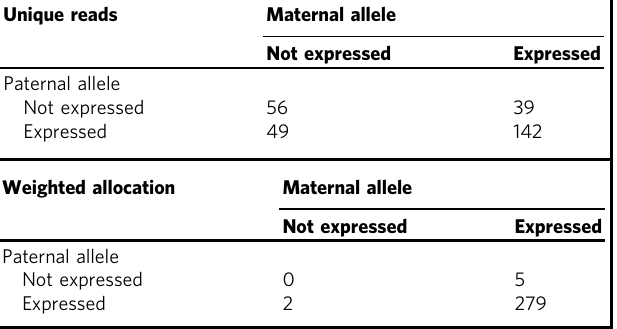
Table 1 Cross-tabulation (2 ´ 2 table) of maternal and paternal allelic expression for Mtdh gene with unique reads and weighted allocation counts. The unique counts resulted in 88 cells with monoallelic expression while only seven monoallelic calls were seen with weighted allocation